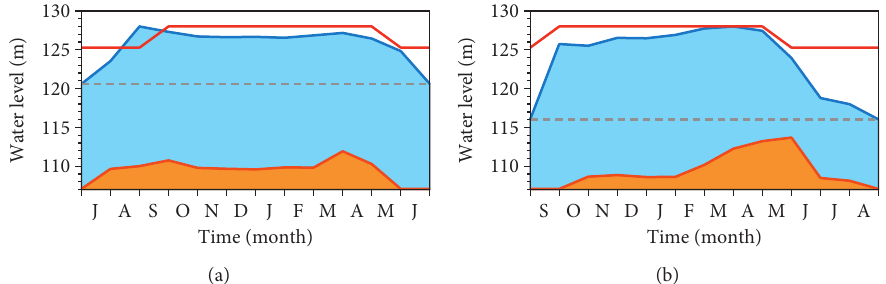
Figure 5: Reservoir rule curves for the July-June scheme (a) and September-August scheme in historical time (1969–2008). The red line is the flood limited curve. The blue/orange line is the lower/limited water supply curve. The gray dash line indicates the threshold of annual and carryover storage.